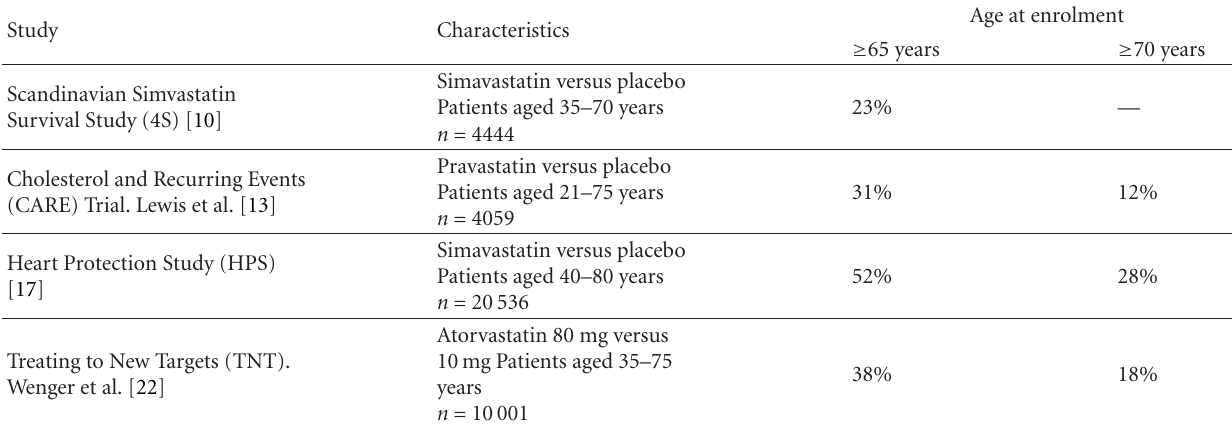
Table 1: Proportions of older patients enrolled in pivotal statin